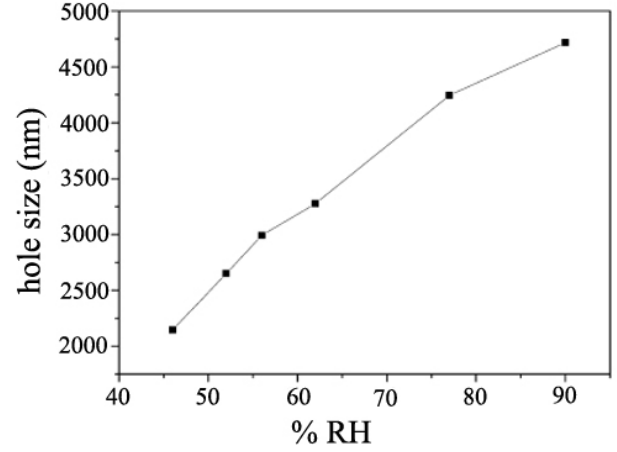
Figure 9. Curve of the pore size of PS honeycomb films versus the relative humidity, with copyright permission from